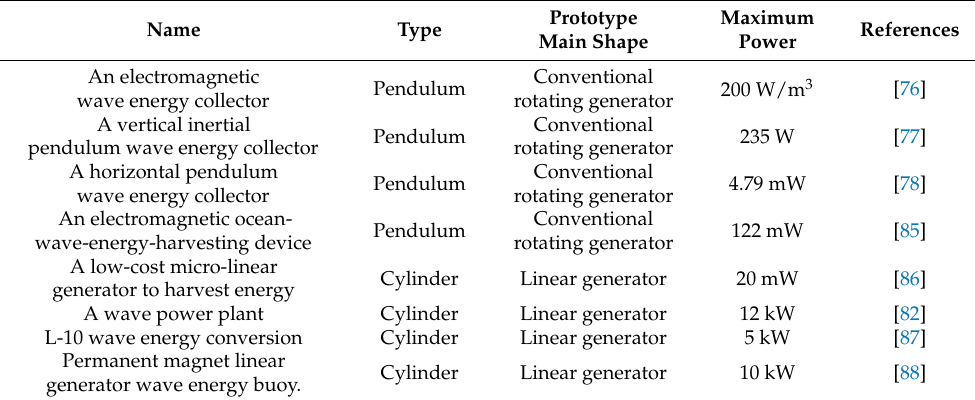
Figure 4. Electromagnetic generator (EMG)-based power take-off (PTO); ( a ) mechanical transmission PTO [81], reproduced with permission from the authors; ( b ) permanent-magnet PTO [82], reproduced with permission from the authors; ( c ) hydraulic flywheel PTO [83], reproduced with permission from CC BY 4.0; ( d ) pendulum-based PTO [84], reproduced with permission from CC BY 4.0. Table 1. Typical electromagnetic generator (EMG)-based power take-off